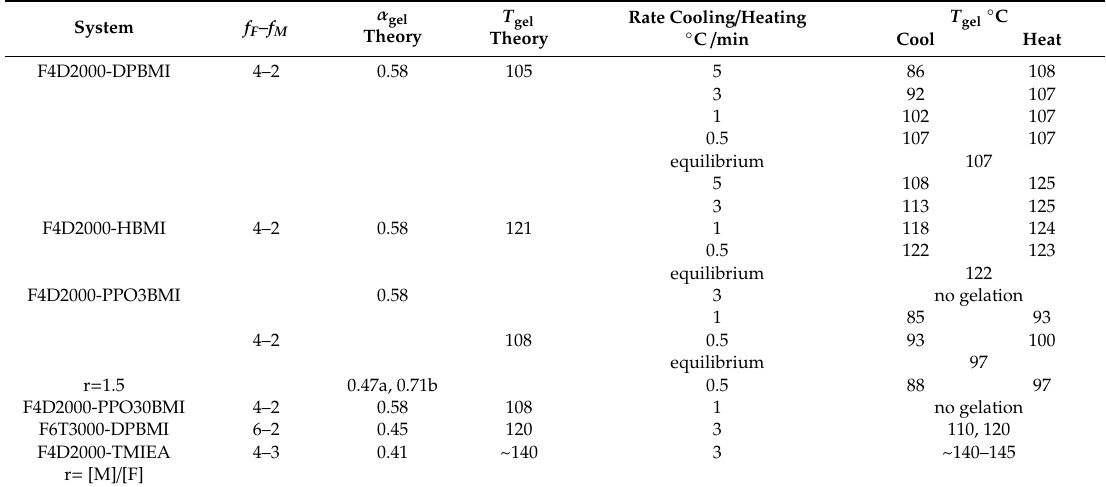
Table 1. Characterization of thermoreversible network